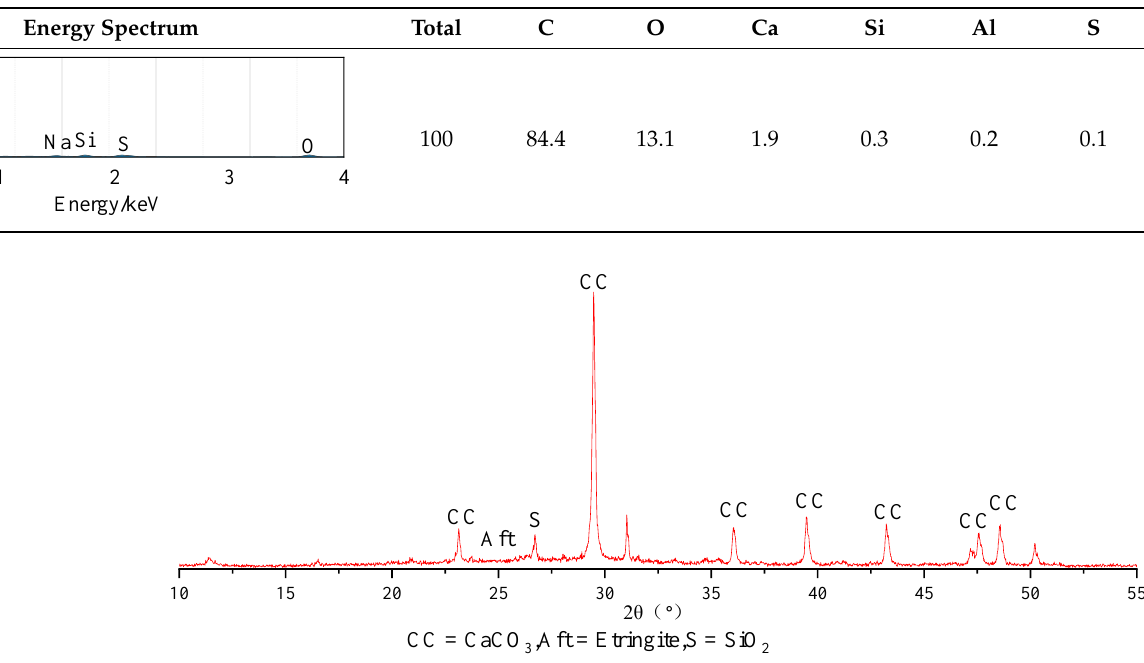
Figure 4. XRD analysis results of wastewater particles. Table 2. Chemical characteristics of wastewater and cement.